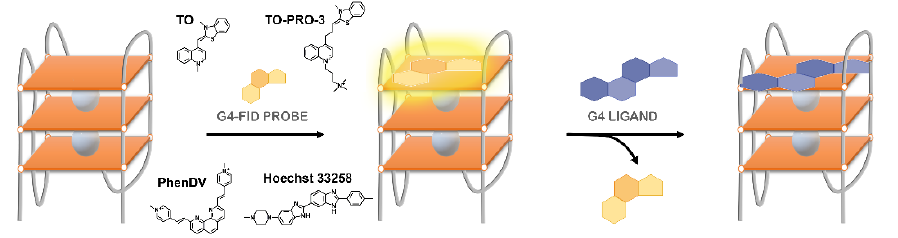
Figure 22. Schematic general representation of G4-FID experiments. Chemical structures of TO, TO-PRO-3, Hoechst 33258 and PhenDV.